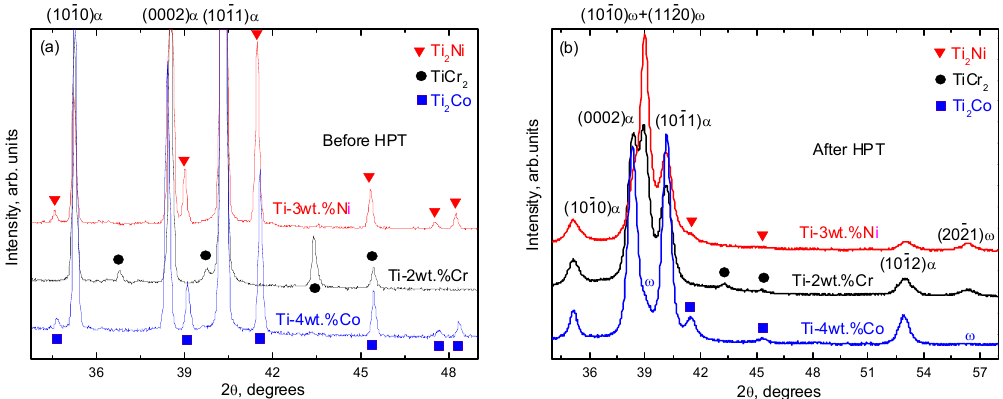
Figure 2. X-ray diffraction patterns of Ti–3wt.% Ni (upper curves), Ti–2wt.% Cr (middle curves), and Ti–4wt.% Co (lower curves) annealed at 600 °С, 2774 h ( a ) before HPT and ( b ) after HPT.